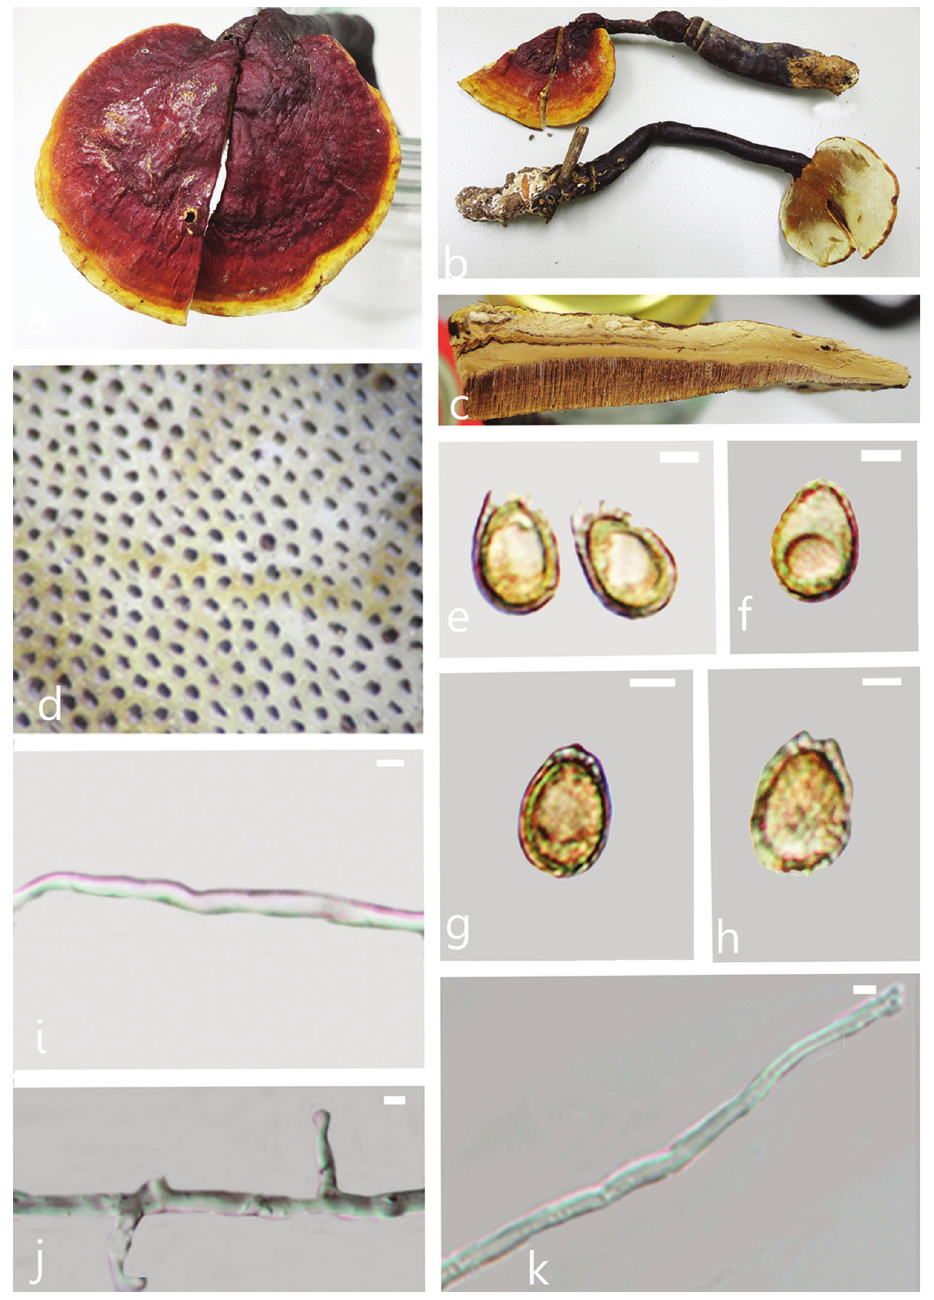
Figure 2. Ganoderma sichuanense (MFU 16-2668). A upper surface B lower surface C cut side of pileus D pore surface E – H spore I generative hyphae J binding hyphae K skeleton hyphae. Scale bars: 10